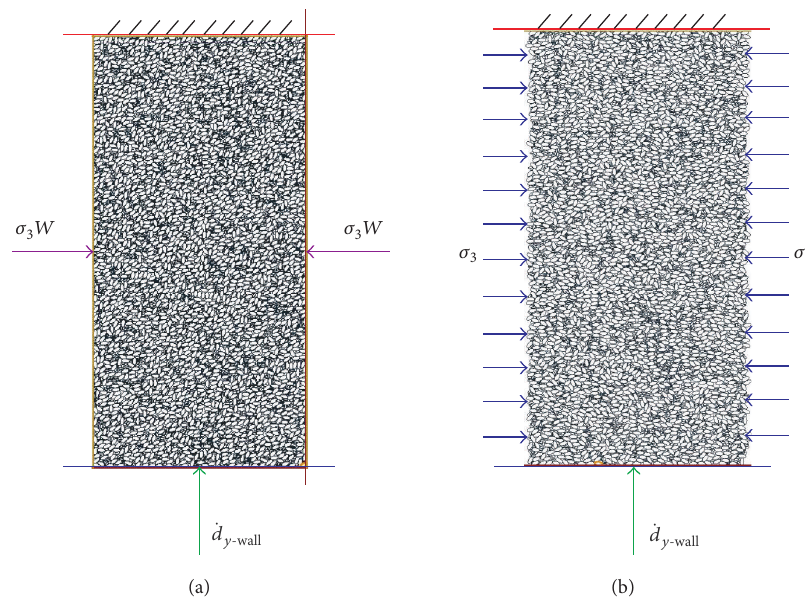
Figure 7: The other two boundaries used for